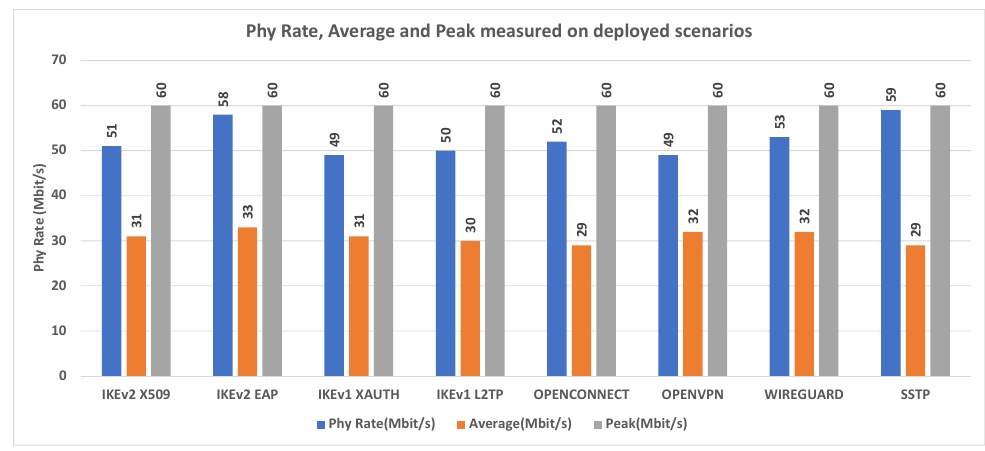
Figure 23. Phy Rate, Average and Peak measured on deployed scenarios. In Figure 24 the RTT data collected during the VPN connection tests with wired devices are